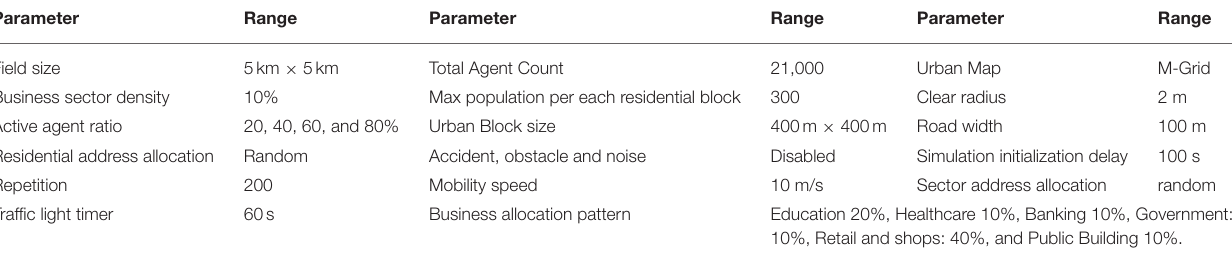
TABLE 2 | Simulation set-up parameters (source: the